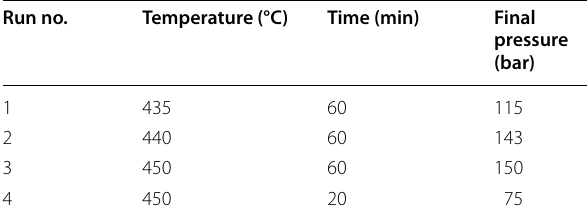
Table 1 Experimental conditions for batch biojet fuel preparation (catalyst: 2.5 vol%) Run no.